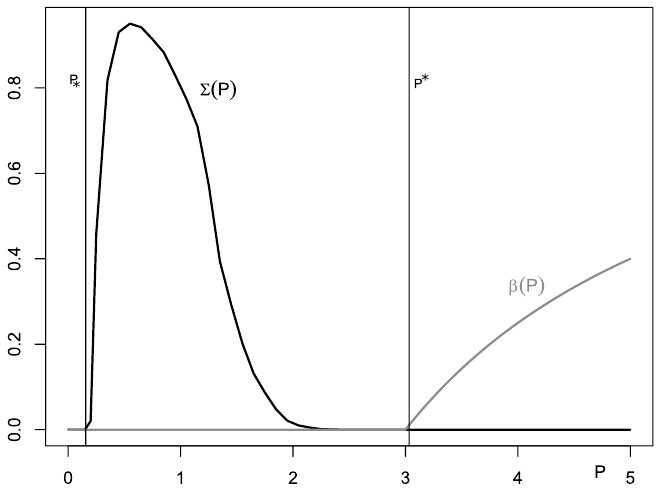
(cid:82) S ( τ , P ) d τ ( T is assumed to be uniformly distributed Figure 3. Black: equilibrium solution Σ ( P ) = between ˇ τ = 2, ˆ τ = 10, ψ B = 1, γ = 0.2). The support of that function is in the interval [ P ∗ , P ∗ ] , as expected. Gray: β ( P ) = β 0 max { 0,1 − π 0 / P } , where we use π 0 = 3 and (for this figure) β 0 =